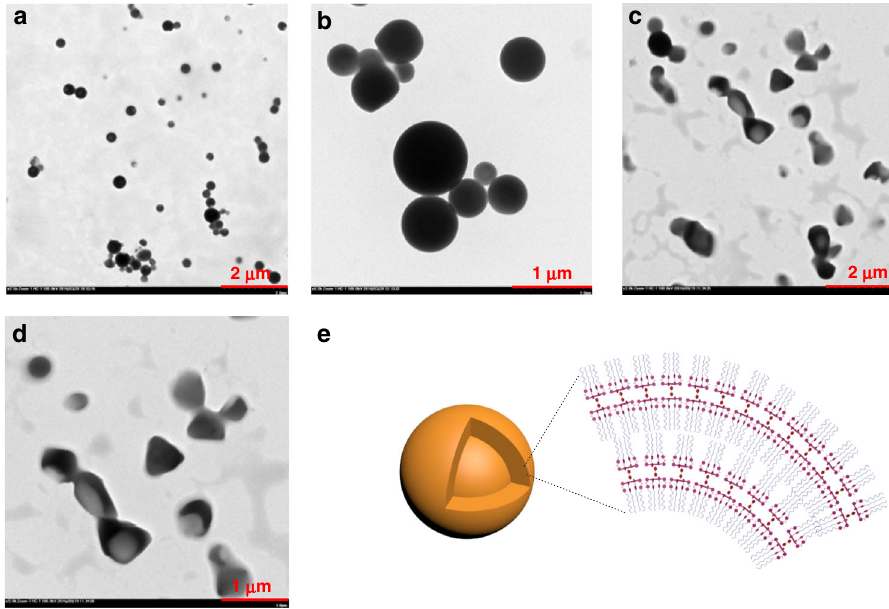
Fig. 7 TEM images of self-assemblies formed from 6 2 (cid:129) 9 . a , b TEM images of 6 2 (cid:129) 9 (1.00 × 10 − 3 M) in aqueous solution. c , d TEM images of 6 2 (cid:129) 9 (1.00 × 10 − 3 M) with the addition of 4 equiv n -Bu 4 NCl in aqueous solution. e Schematic representation of the self-assembly of 6 2 (cid:129)